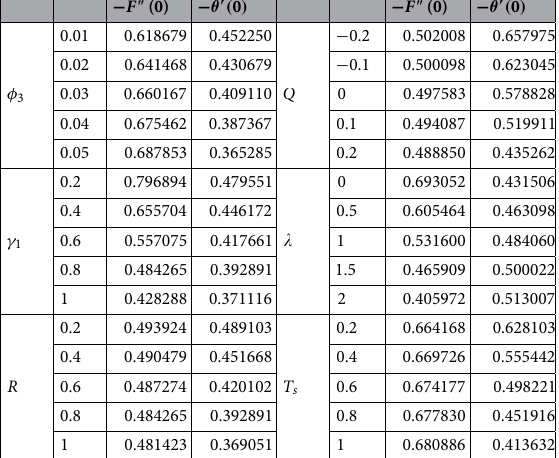
F 0 ) and θ ′ ( 0 ) with respect to fluid flow ′′ ( − −